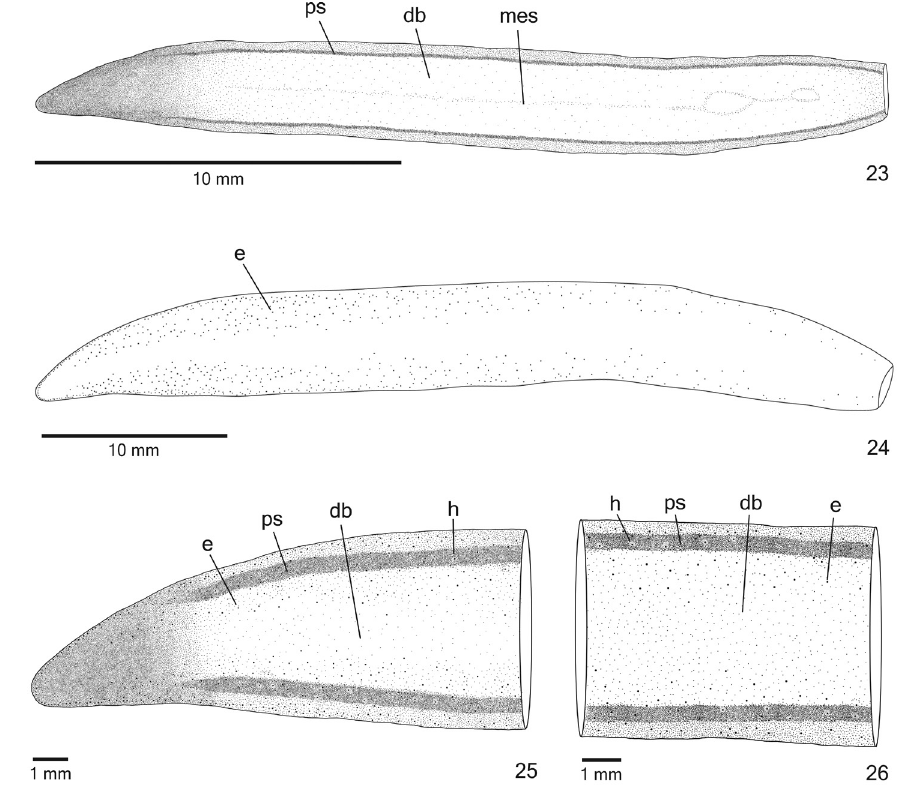
Figures 23–26. Cratera nigrimarginata sp. n., dorsal view, 23 holotype, pattern of pigmentation 24–26 specimen MZU PL.00220, eye pattern ( 24 ), anterior extremity ( 25 ) and median third of body ( 26